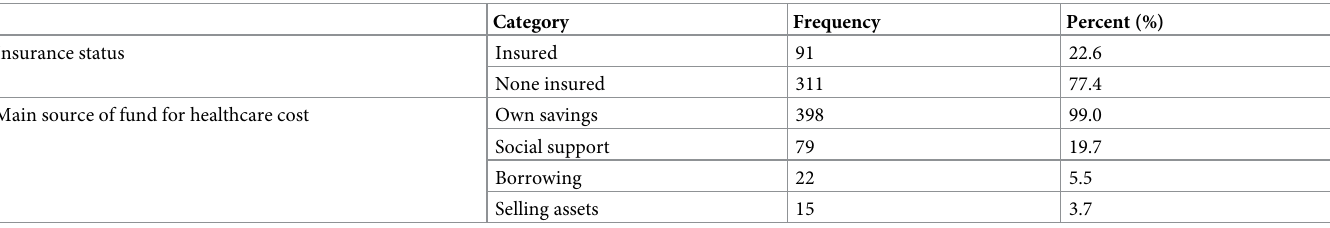
Table 5. Households coping mechanism for healthcare cost among households in Debre Tabor town, Ethiopia,